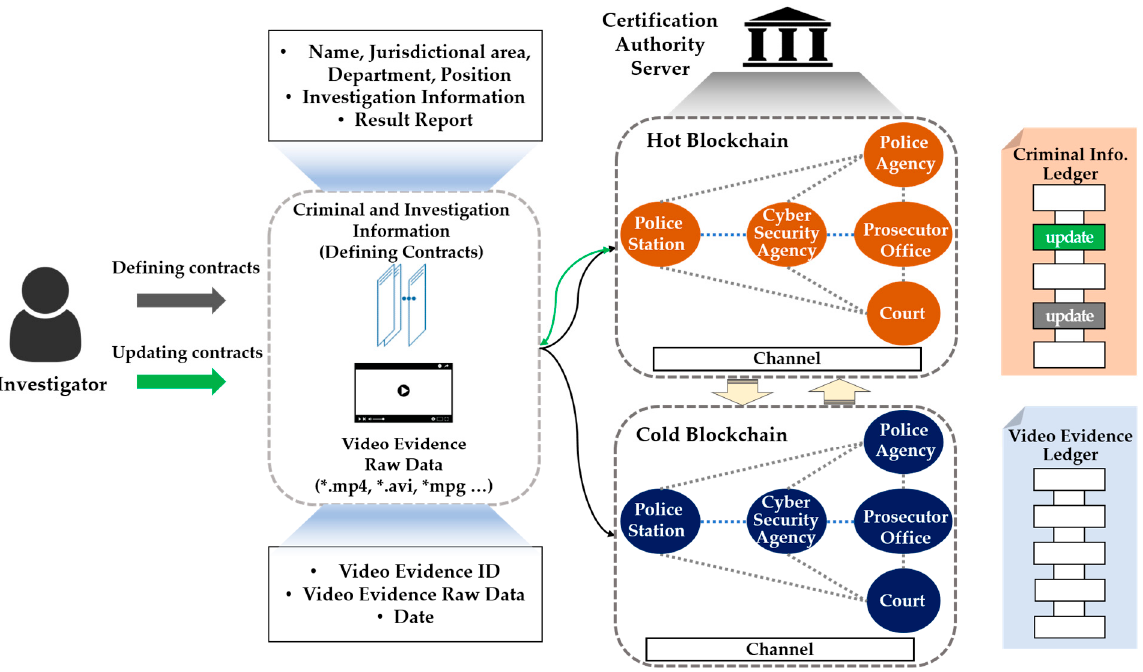
Figure 3. Two ‐ level blockchain system. Figure 3. Two-level blockchain